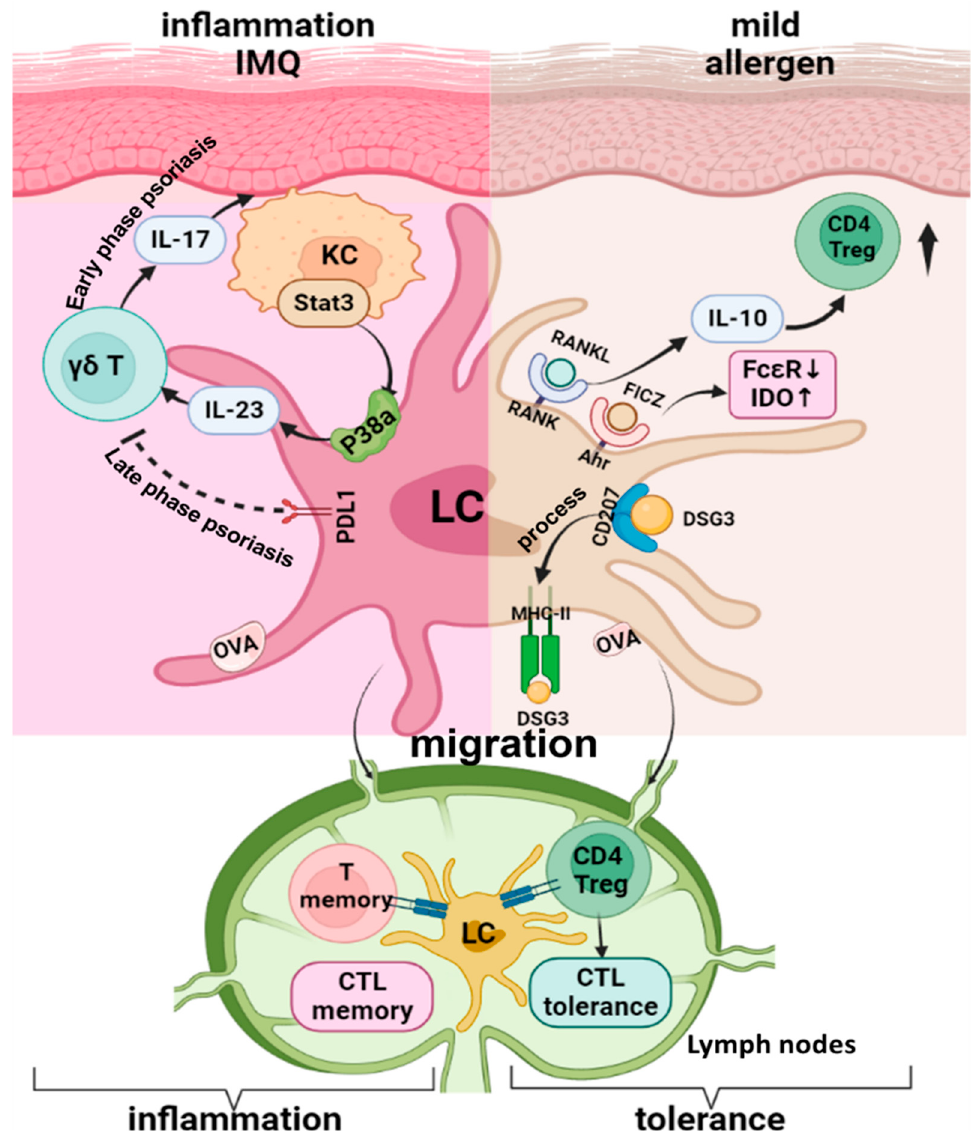
Figure 2. Langerhans Cells in Inflammatory Skin Diseases . Right panel of the figure showed the tolerance induction function of LC in mild allergen induced contact hypersensitivity (CHS). RANKL expressed by KC inhibits CHS responses by augmenting the capacity of LC to expand Treg.